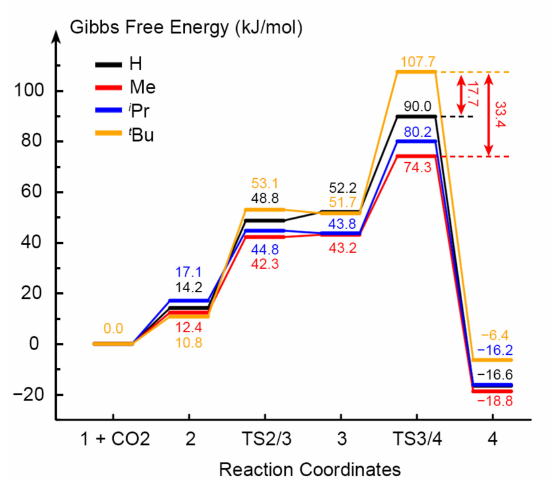
Figure 6. Free energy profiles of the total reaction of CO 2 hydrogenation on R-substituted (R = H, Me, i Pr, t Bu)